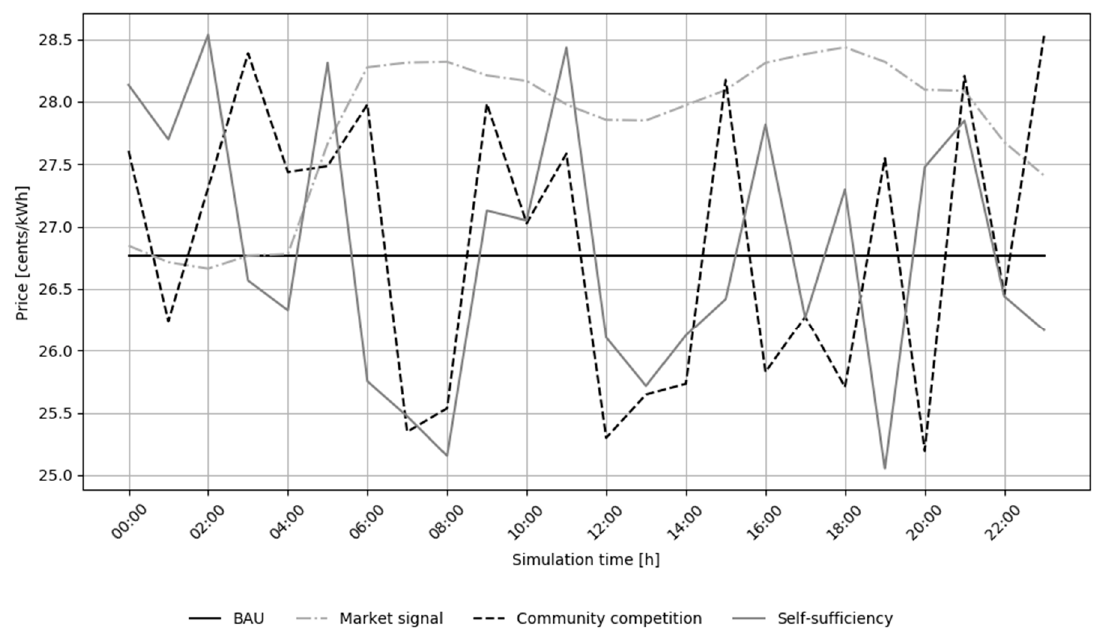
Figure A4. Electricity tariffs in the investigated scenarios for an exemplary 24 h.